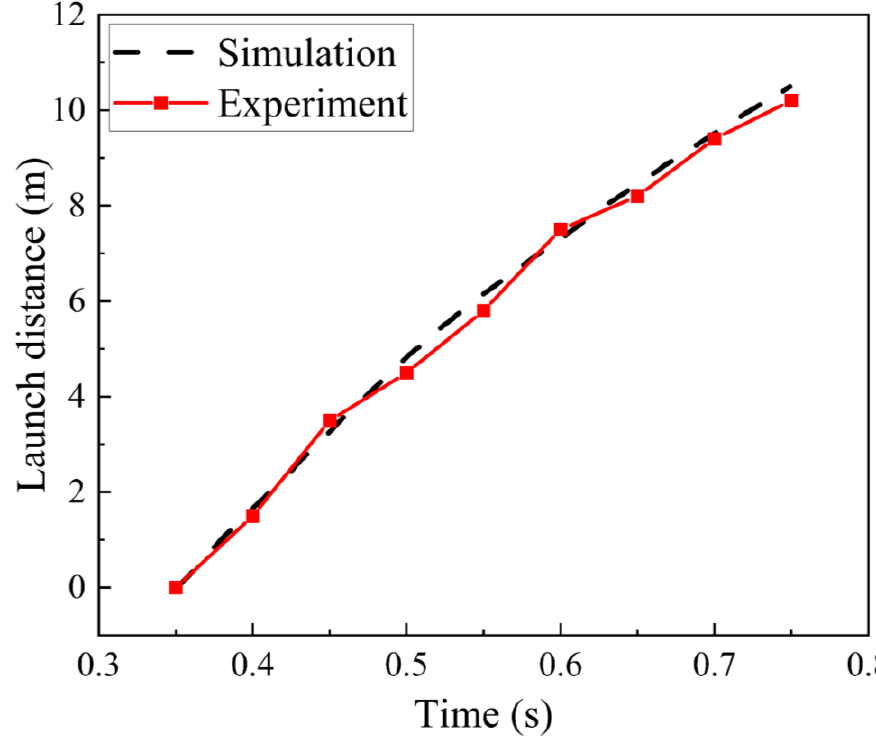
Figure 13. Comparison of launch distance between simulations and experiments.